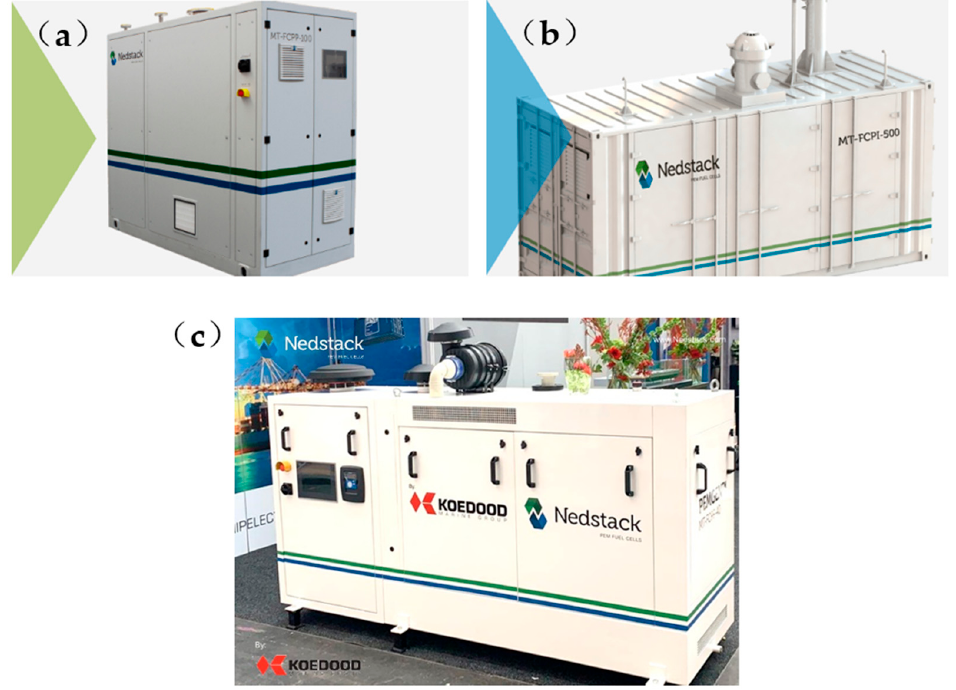
Figure 22. ( a ) Images of 100 kW PemGen MT-FCPI-100 [111]; ( b ) PemGen 500 kW MT-FCPI-500 [111]; ( c ) Nedstack extended long-life (XXL) PEMFC stacks [112].